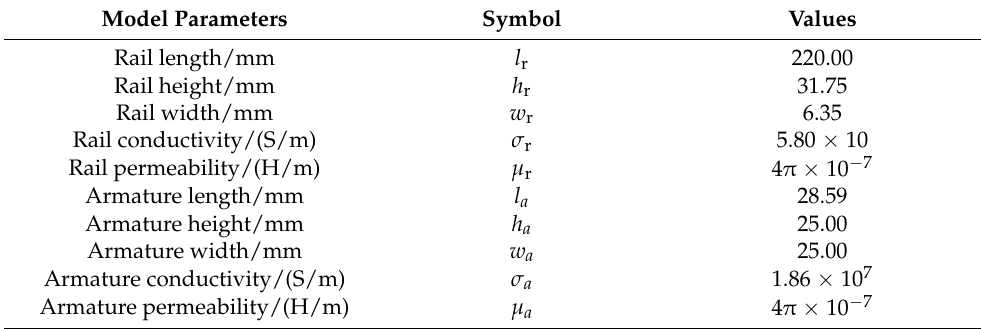
Table 4. Parameters of armature and rail model.